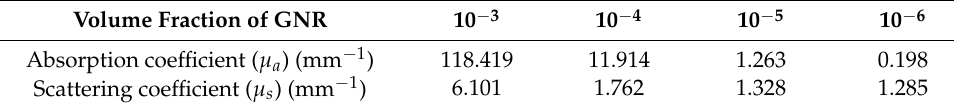
Table 6. Optical properties of tumor with GNR for various volume fractions.